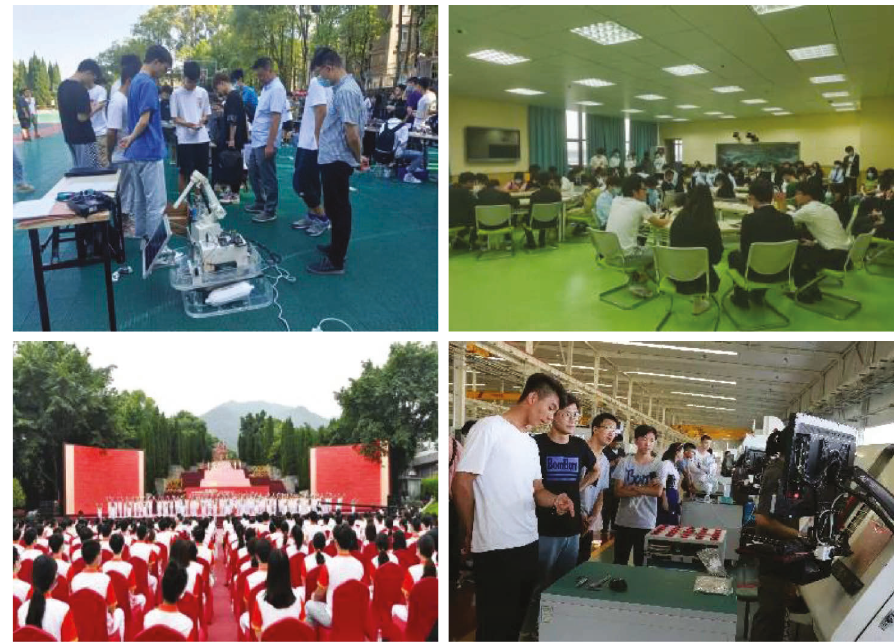
Figure 2: Innovative activities in which college students